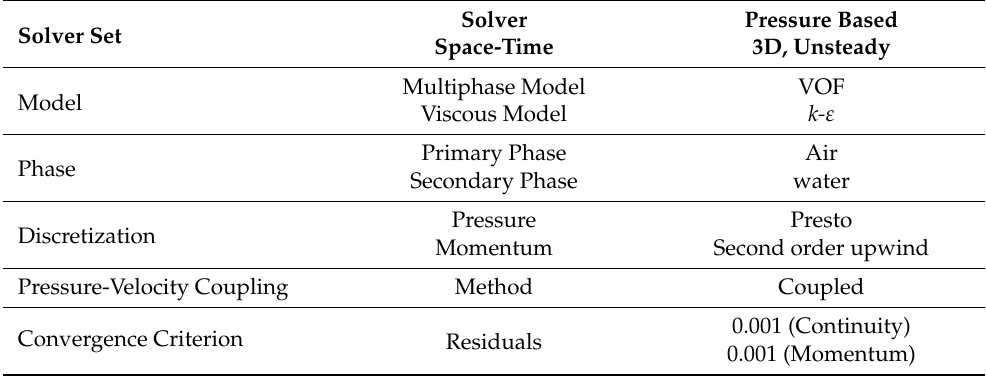
Table 3. Numerical model details.